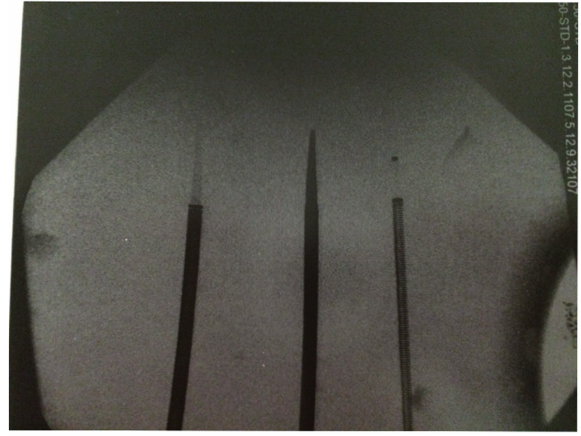
figure 5 - Radio-opacity. from left to right: Gw, NHD,